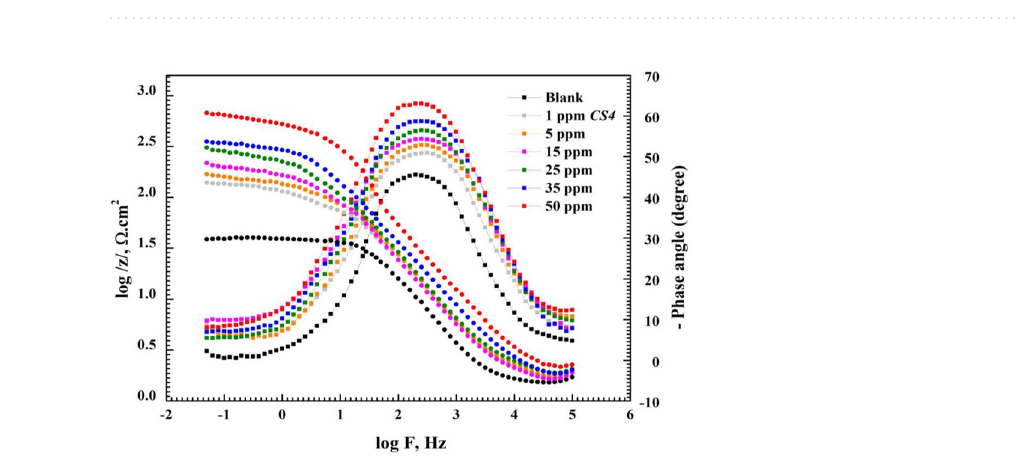
Figure 4. Nyquist plots for CS -metal in 1 M HCl in the absence and presence of various concentrations of CS4 at room temperature.